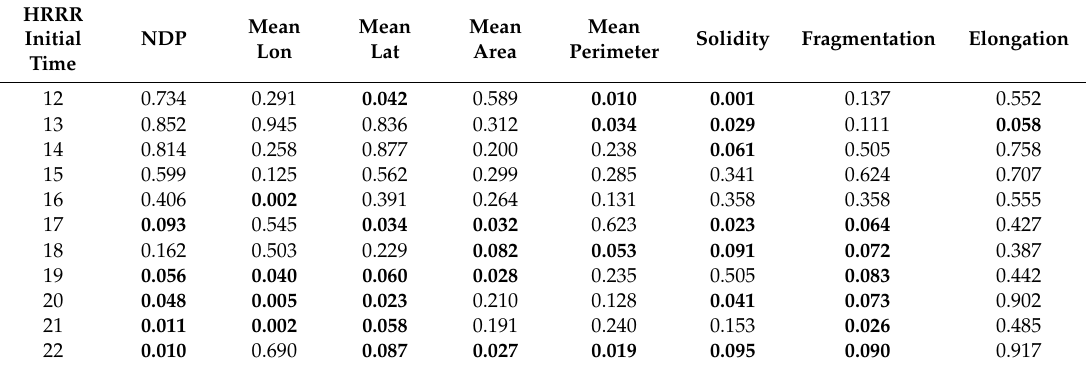
Table 4. Mann–Whitney U p -values for 12.7 mm h − 1 (0.5 in h − 1 ) threshold for Jul 31, 2016 case. Bold font face indicates significance at 90% confidence